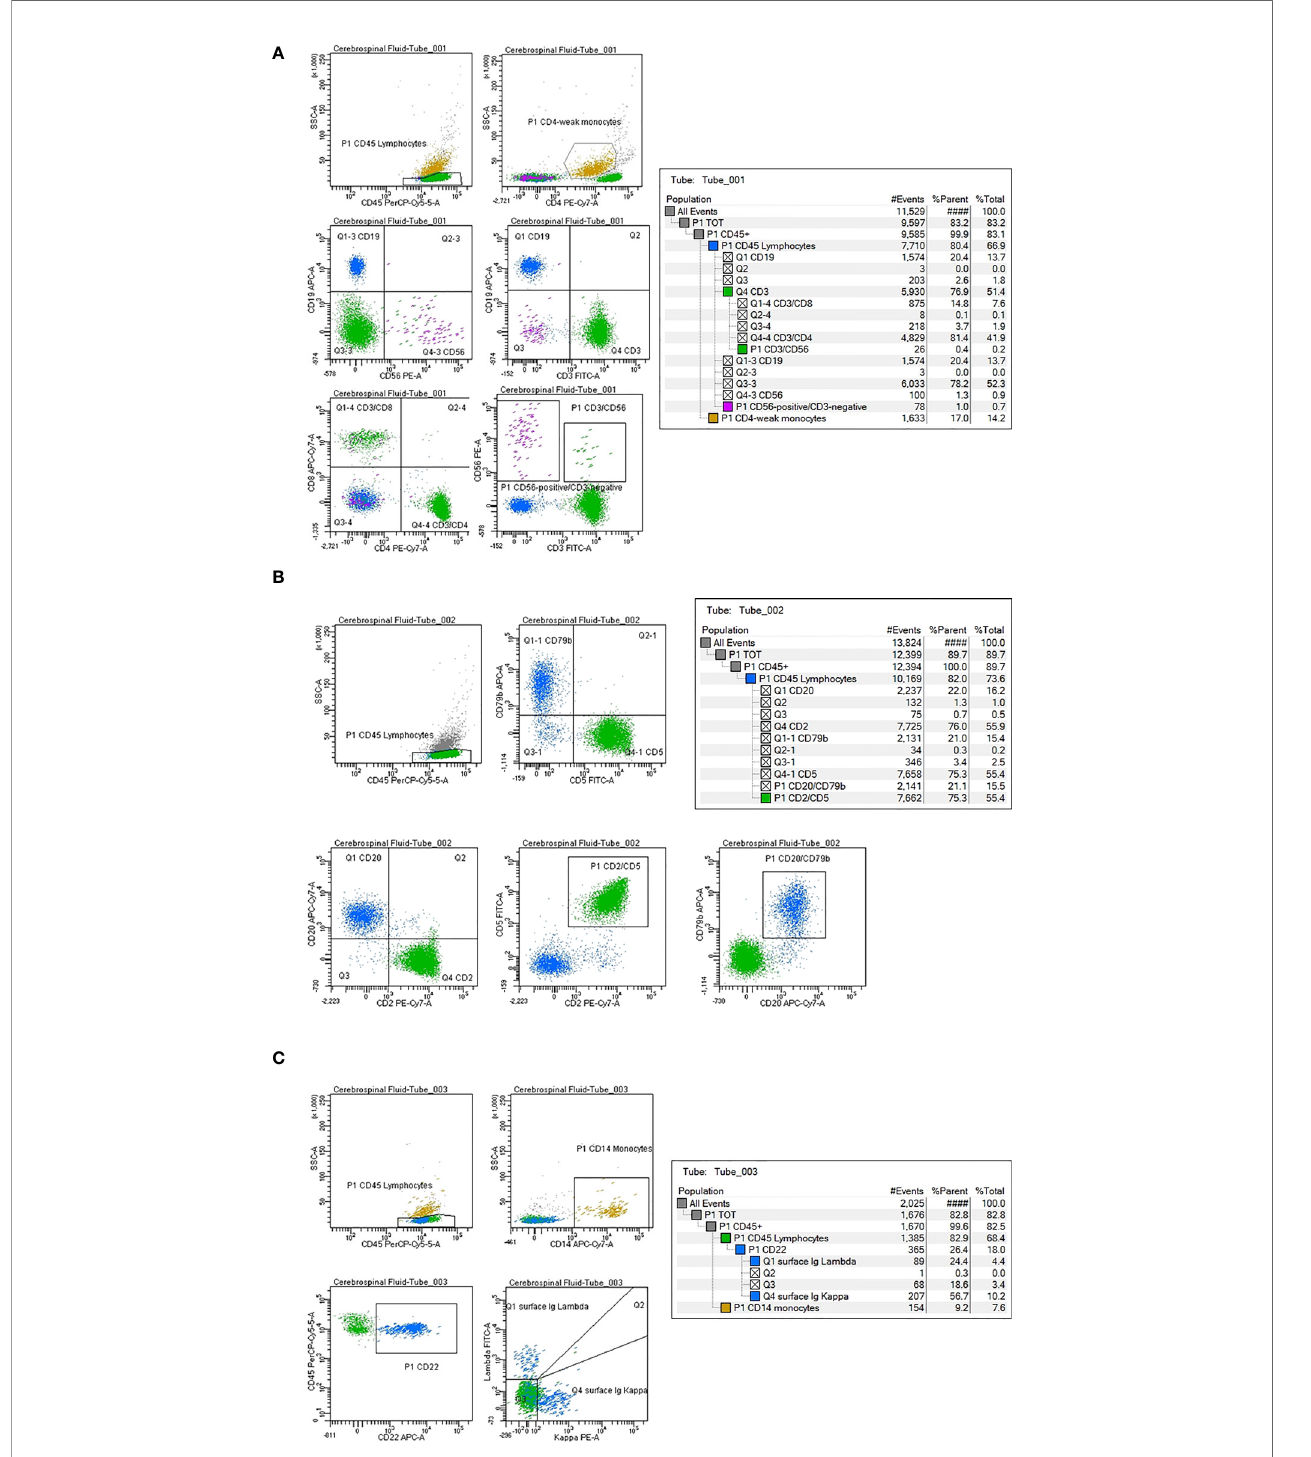
FIGURE 2 | Cerebrospinal fl uid (CSF) fl ow cytometry characterization in a case of diffuse large B-cell lymphoma negative for disease in fi ltration. Cell count: 24 cells/µl. The CSF lymphocyte immunophenotype is reported as percentage of positive cells within the lymphoid population, identi fi ed as CD45-strong/low SSC. (A) Tube number 1: Green color has been utilized to mark CD3 CD4 CD8-positive T lymphocytes; purple for CD56-positive cells, blue for CD19-positive B lymphocytes and dark yellow for CD4-weak monocytes. (B) Tube number 2: Green color has been utilized to mark CD2 CD5-positive T lymphocytes; blue for CD79b CD20-positive B cells. (C) Tube number 3: Blue color has been utilized to mark CD22-positive B lymphocytes. The Ig light chain expression shows a normal kappa/lambda ratio. Dark yellow marks CD14-positive